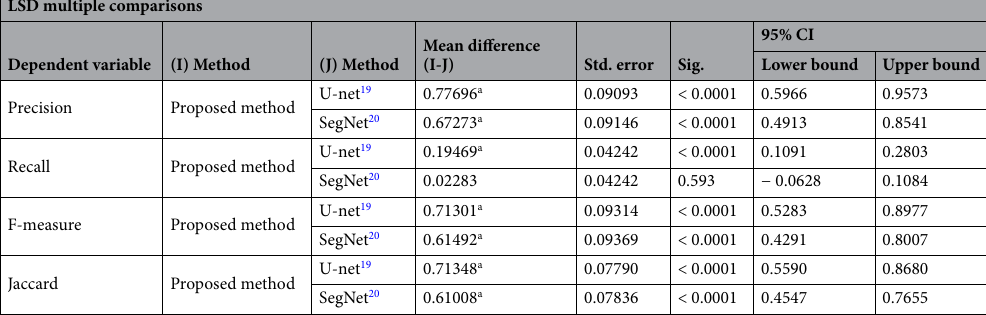
Table 4. Multiple comparisons for the segmentation of HSILs or higher (SQCC): Fisher’s LSD test. a The proposed method is significantly better than the benchmark methods (U-net 19 and SegNet 20 ) ( P < 0.0001 ).